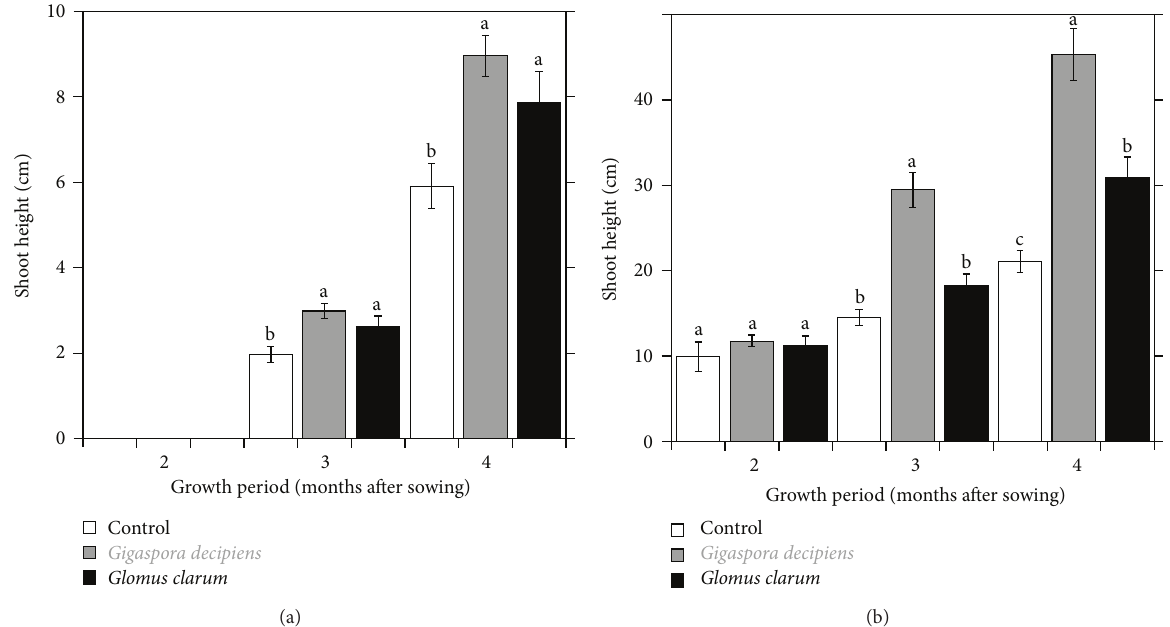
Figure 1: Shoot heights of M. paniculatus (a) and A. saman (b) inoculated with AM fungi two, three, and four months after sowing. Gray bar: G. decipiens ; black bar: G. clarum ; white bar: control. Different letters for the same month indicate a significant difference at 𝑃 < 0.05 as determined by the Tukey HSD test ( 𝑛 = 20 ). Vertical bars represent standard errors of mean (SE).